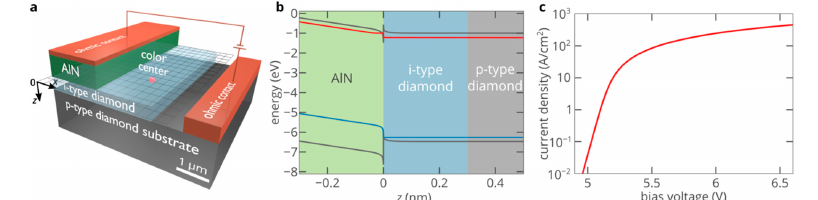
Figure 3. ( a ) Schematic of the AlN/diamond single-photon emitting diode (SPED) with a color center in i-type diamond region. ( b ) Energy band diagram of the SPED shown in panel a in the vicinity of the AlN/diamond heterojunction at a forward bias voltage of 6.5 V. The grey lines show the conduction and valence bands, the red line indicates the quasi-Fermi level for electrons and the blue line shows the quasi-Fermi level for holes. ( c ) Dependence of the current density at the top n-type contact on the bias voltage for the SPED shown in panel a. Figure 3b shows the simulated energy band diagram of the AlN/diamond heterostructure at a forward bias voltage of 6.5 V. It is clearly seen that there is a conduction-band offset (CBO) of about